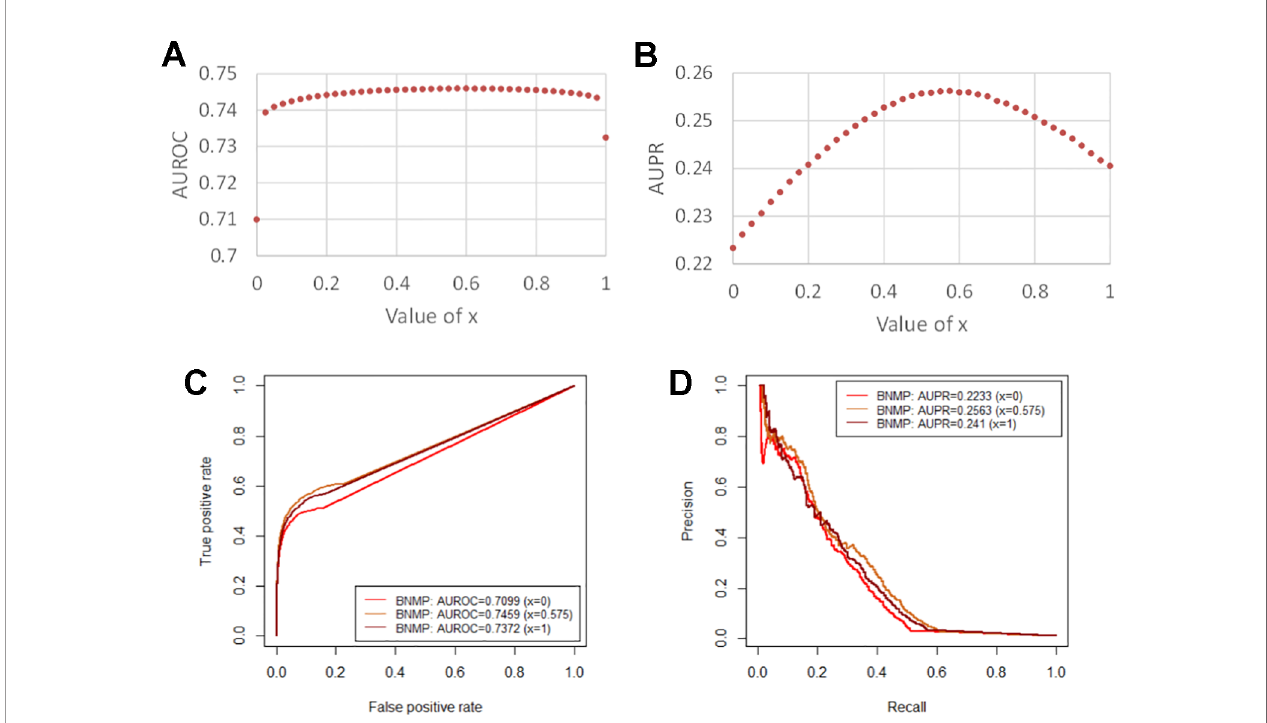
FIGURE 2 | Prediction performance of BNMP with network 1. (A) In fl uence on AUROC values by different balance parameter values. (B) In fl uence on AUPR values by different balance parameter values. (C) ROC curves of BNMP with the different balance parameter values. (D) PR curves of BNMP with the different balance parameter values.